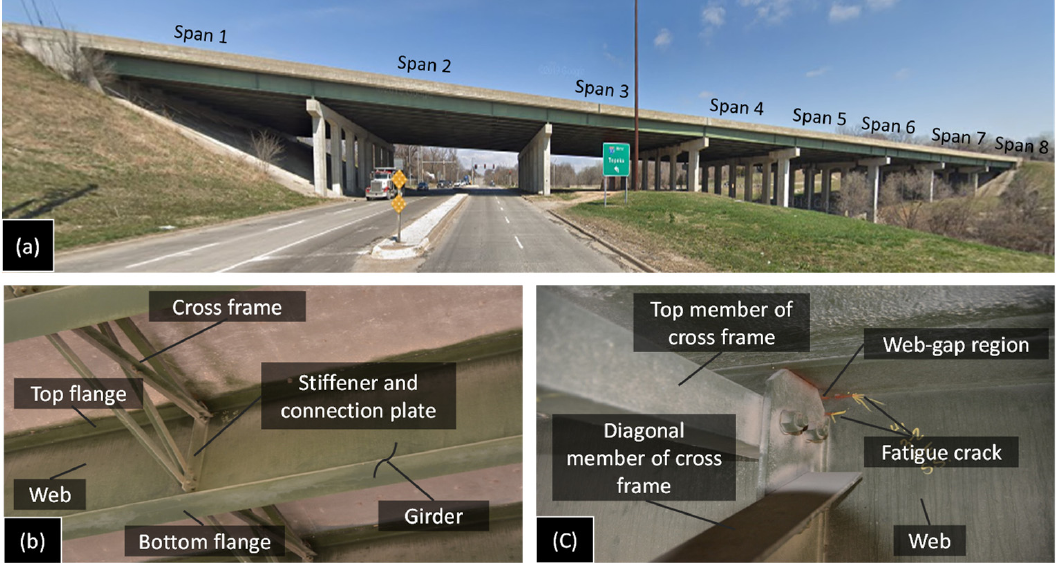
Figure 10. I-70 highway bridge: ( a ) span layout of the bridge, ( b ) cross-frame between the adjacent girders, and ( c ) detail of the web-gap region with distortion-induced fatigue cracks.